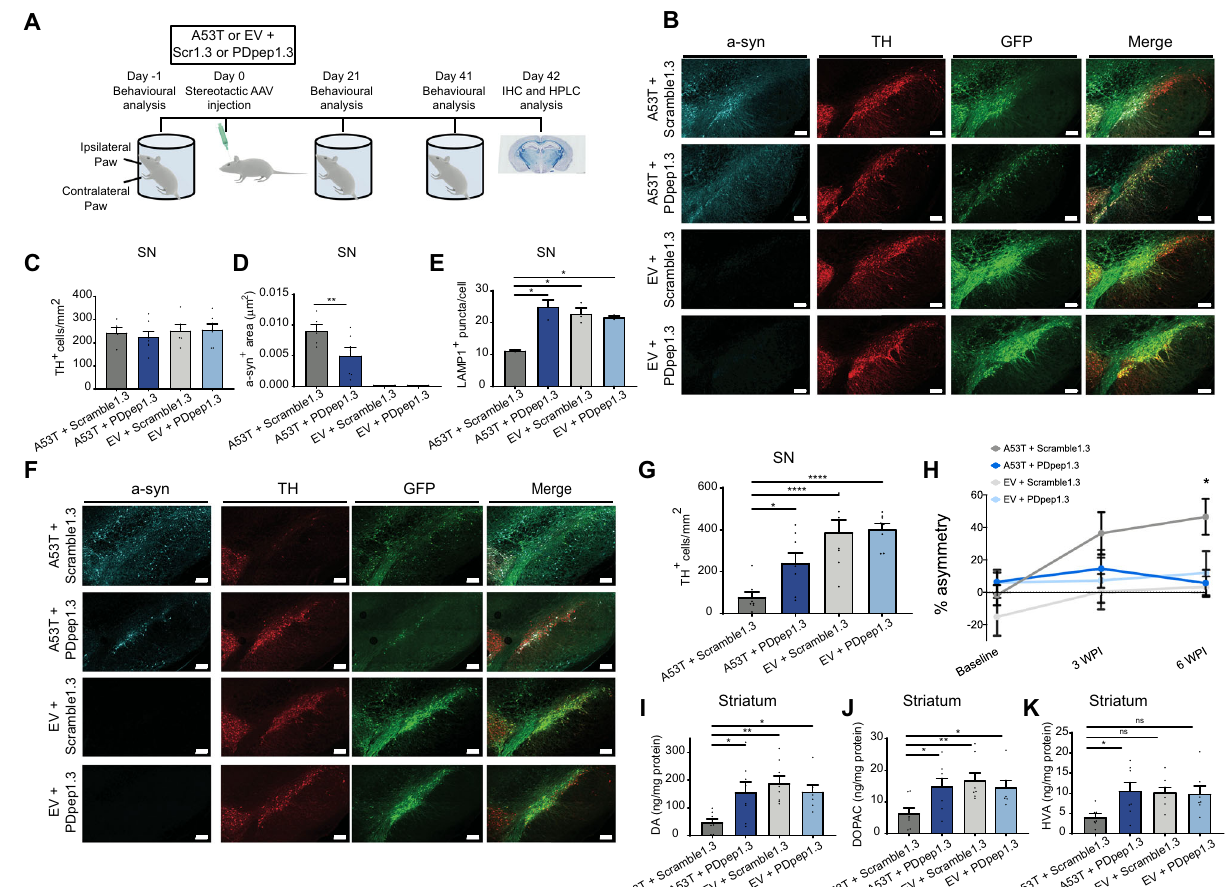
Fig.5|PDpep1.3reducesa-synlevelsanda-syn-mediatedneurodegenerationin a preclinical rat model of PD. A Experimental design for testing PDpep1.3 versus Scramble1.3inAAV-A53Ta-synratmodel(createdusinganimagefromBiorenderat http://www.biorender.com/). B Representative images of immunostaining (with anti-a-syn or anti-TH antibodies) and native GFP fl uorescence in substantia nigra (SN) of rats injected with low titer A53T a-syn or empty vector (EV) plus Scram- ble1.3-GFP or PDpep1.3-GFP (scale bars=200 μ m). C TH + cell counts (A53T +Scramble1.3, n =5 rats; A53T+PDpep1.3, n =7 rats; EV+Scramble1.3, n =6 rats; EV +PDpep1.3, n =7 rats), D quanti fi cation of a-syn + area (one-way ANOVA, F (3, 21)=24.89; P <0.0001 followed by Dunnett ’ s post-test; A53T+Scramble1.3, n =5 rats;A53T+PDpep1.3, n =7rats;EV+Scramble1.3, n =6rats;EV+PDpep1.3, n =7rats), and E LAMP1 + puncta counts inSN at 6 weekspost-injection oflowtiter A53Ta-syn or EV plus Scramble1.3-GFP or PDpep1.3-GFP (nested one-way ANOVA, F (3, 8)=5.780; P =0.0211 followed by Dunnett ’ s post-test; n =3 rats per group). F Representative imagesofimmunostaining (with anti-a-synoranti-THantibodies) and native GFP fl uorescence in SN of rats injected with high titer A53T a-syn or EV plus Scramble1.3-GFP or PDpep1.3-GFP (scale bars=200 µ m). G TH + cell counts in